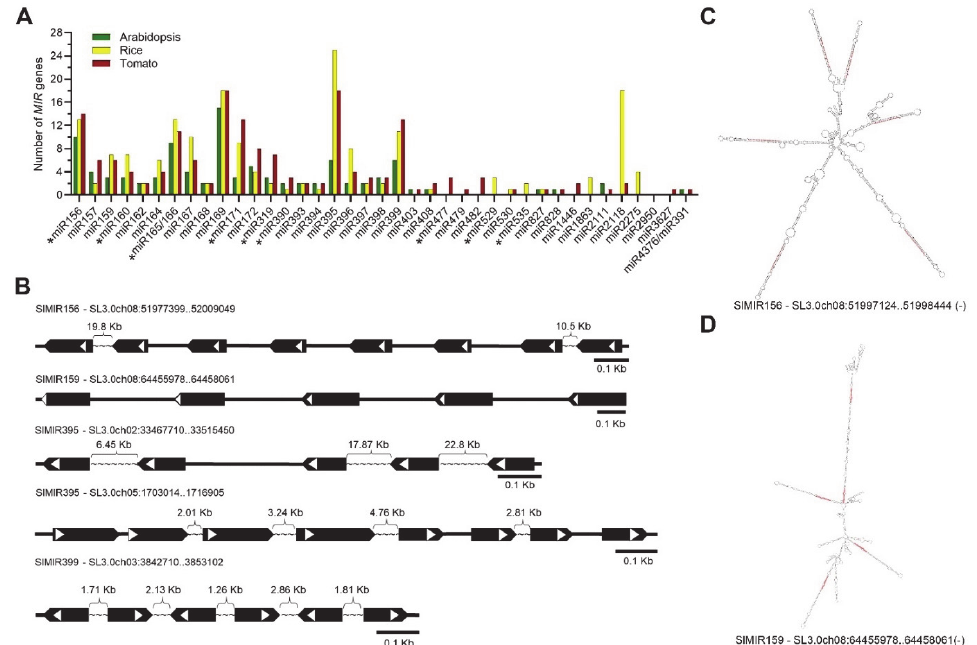
Figure 1. The conserved miRNAs in the tomato genome. ( A ) The number of MIR genes that code the indicated conserved miRNAs in tomato, Arabidopsis, and rice (information is based on miRBase release 22 annotations). Deeply conserved miRNAs are marked by *. ( B ) Schematic illustrations of identified MIR gene clusters and their locations in the tomato genome. Black pentagons represent predicted pre-miRNA regions and white triangles indicate the locations of respective mature miRNAs. Tilde symbols indicate omitted nucleotides and the distance between two corresponding pre-miRNAs is indicated above them. ( C , D ) RNA secondary structures of sly-miR156 ( C ) and sly- miR159 ( D ) polycistronic precursors. The structures were predicted by RNAfold (http://rna.tbi. univie.ac.at/cgi-bin/RNAWebSuite/RNAfold.cgi, accessed on 30 July 2022). The mature miRNA sequence in each hairpin is marked in red. The location of each precursor in the tomato genome (minus indicates reverse complimentary strand) is indicated